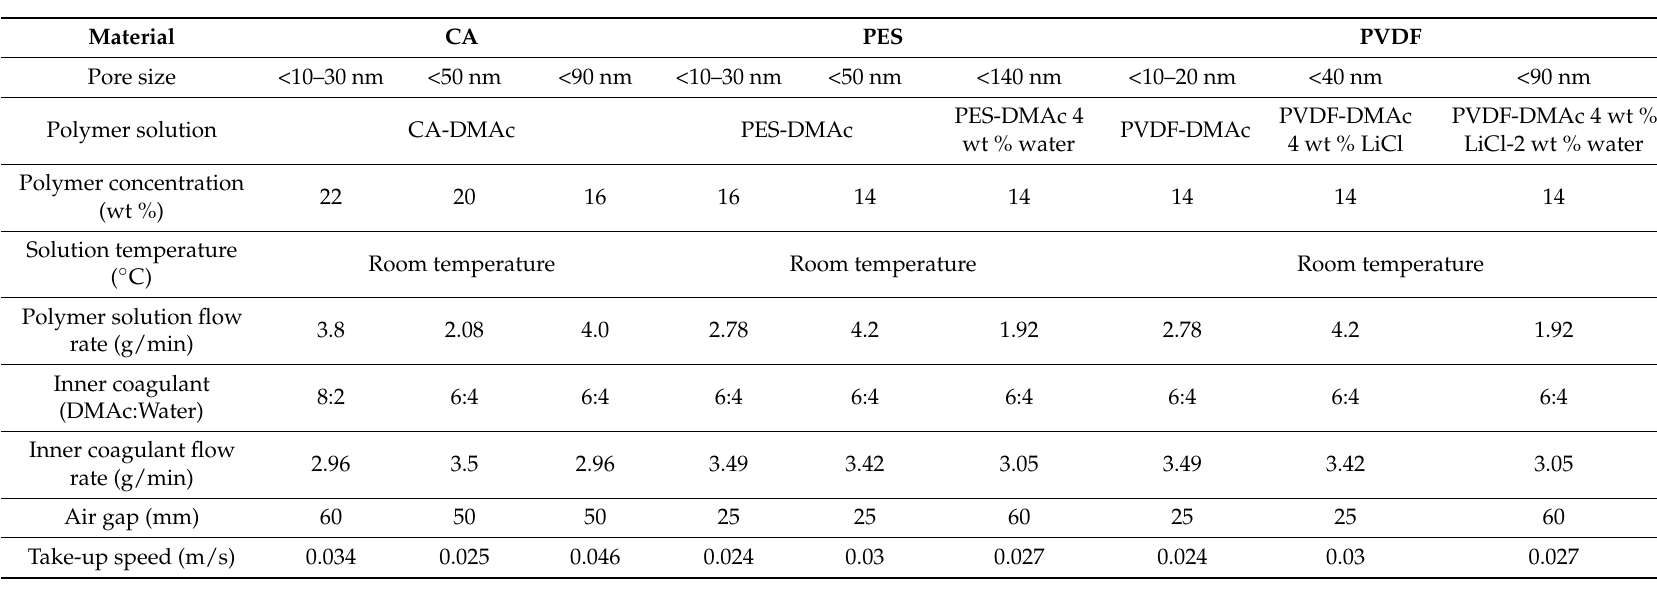
Table 2. Preparation conditions for hollow fiber